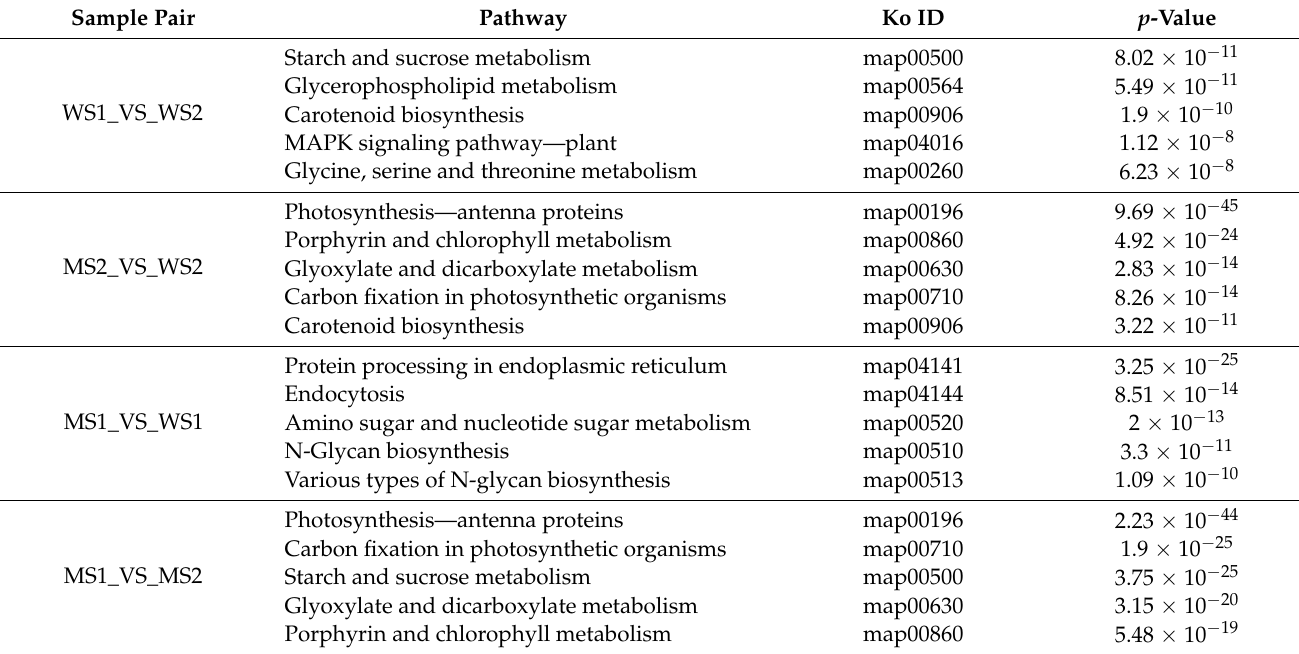
Table 5. Main enrichment pathways of DEG in 4 groups, refer to KEGG